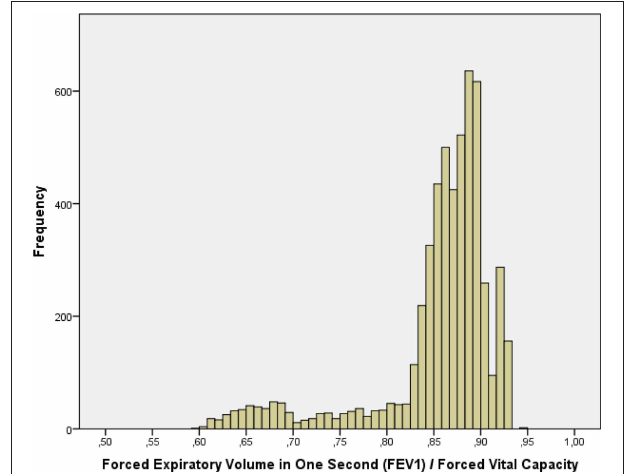
FIGURE 3 | Histogram showing the distribution of the ratio of the forced expiratory volume in 1s divided by the forced vital capacity in the Ural Eye and Medical